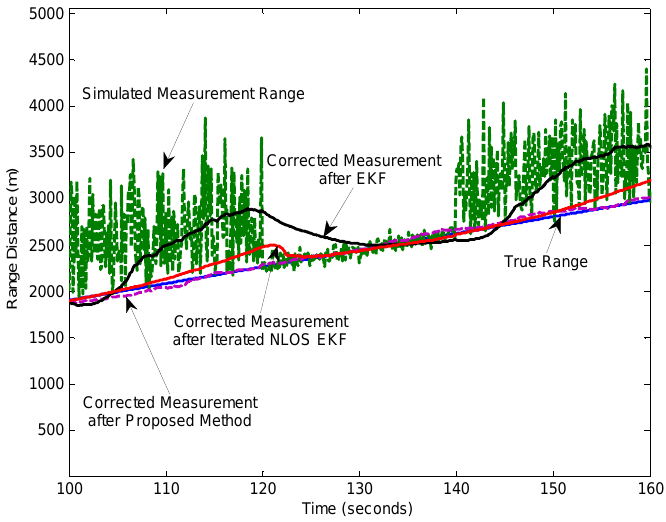
Figure 3. Zoom of the range estimation by three algorithms during 60 seconds.